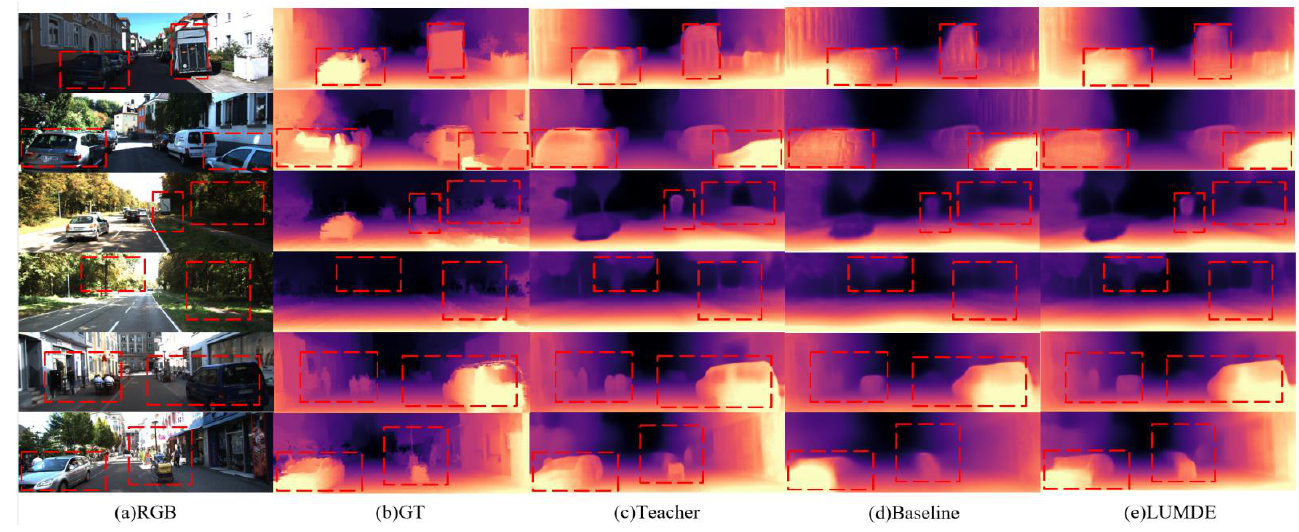
Figure 3. Qualitative comparison of depth ground truth, depth from teacher network, baseline, and